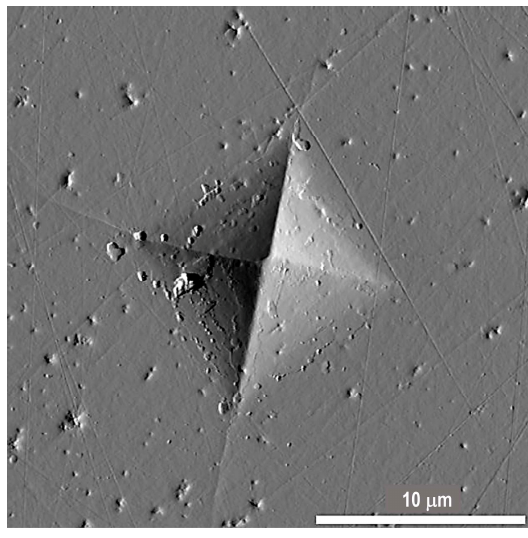
Figure 9. AFM derivative topography image of Vickers indent on nanocrystalline cBN. 4.91-N load.